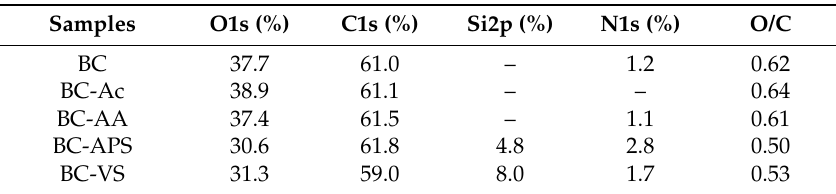
Table 2. Atomic concentrations of elements on the surface of untreated and treated BC acquired by XPS, survey scans.